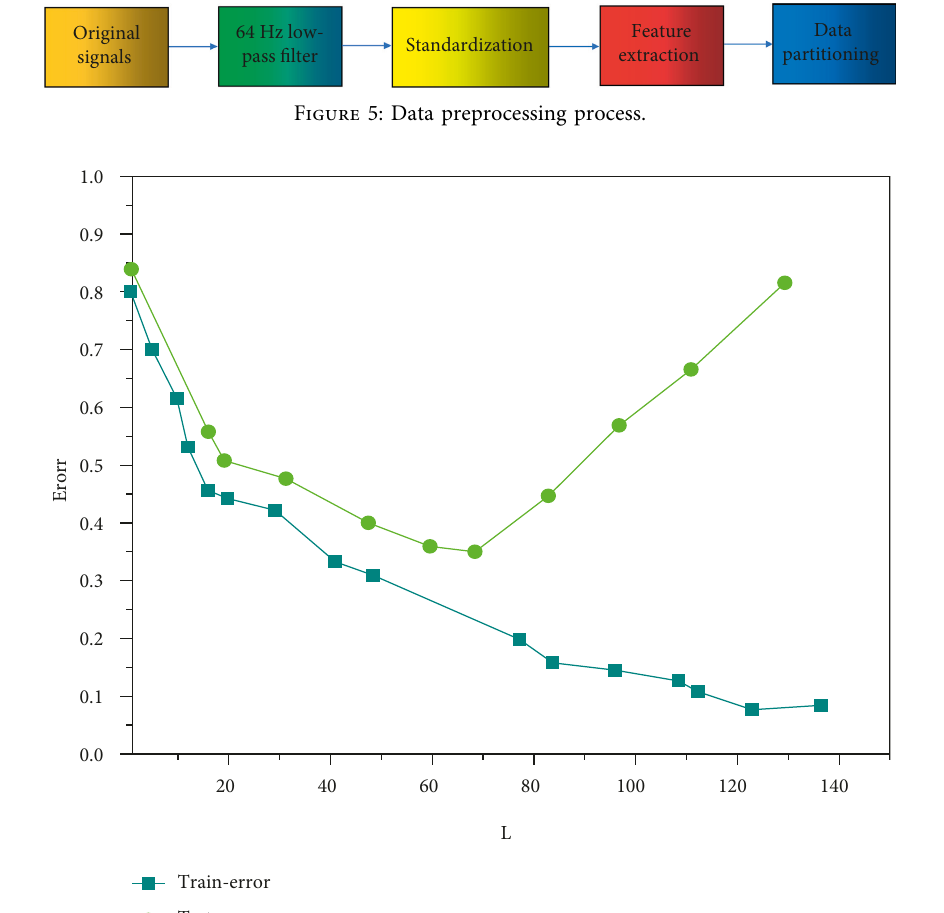
Figure 6: Training error and test error under over fitting.